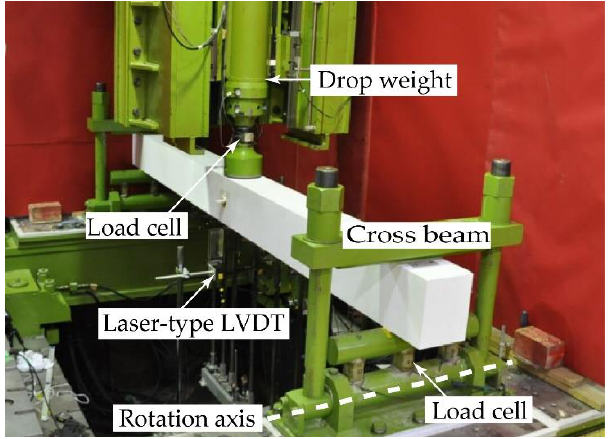
Figure 5. View of the test setup for drop-weight impact loading.